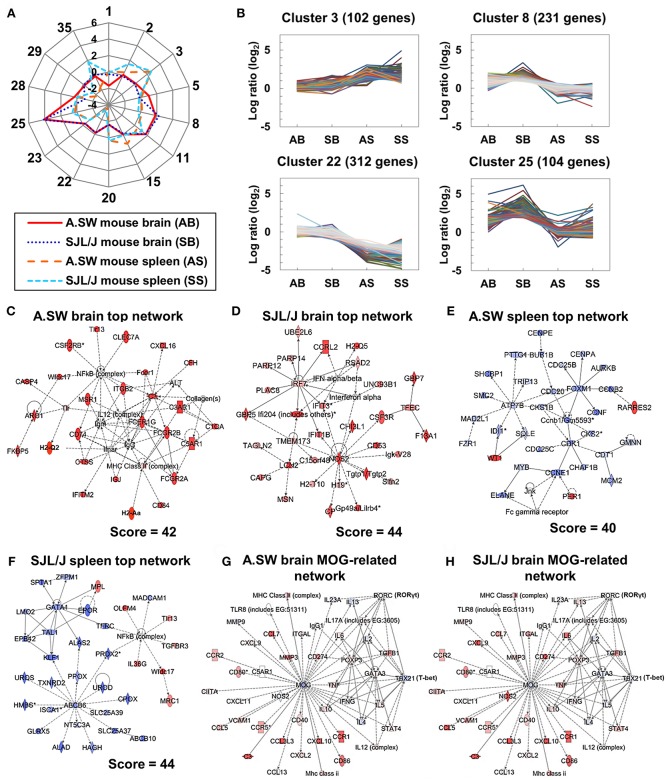
(A,B)
K-means clustering for brain and spleen microarray data from two models. (A) A radar chart of 14 cluster center genes whose log ratios were higher than 1 or lower than −1, at least in one organ or in one mouse strain, compared with controls, among the total 35 clusters. (B) Dynamic expression patterns of four clusters. AB, SB, AS, and SS indicate A.SW mouse brain, SJL/J mouse brain, A.SW mouse spleen, and SJL/J mouse spleen, respectively. We used microarray data from three PP-EAE and three naïve mice of each strain (the total number of mice = 12). Genes in cluster 3 were up-regulated in the spleens of both models. Genes in cluster 8 were up-regulated in the brains of SJL/J mice. Genes in cluster 22 were down-regulated in the spleens of both models. Genes in cluster 25 were up-regulated in the brains of both models. (C–H) Gene networks up-regulated in the brains or down-regulated in the spleens from two models. Transcriptome data at disease peak were clustered and categorized by the Ingenuity Pathway Analysis (IPA) Network Generation. (C) The top network in the brains of A.SW mice was categorized as “Cell-To-Cell Signaling and Interaction,” “Hematological System Development and Function,” and “Immune Cell Trafficking,” which were composed of Fc receptor and complement-related genes. (D) The top network in SJL/J mouse brain was categorized as “Immunological Disease,” “Endocrine System Disorders,” and “Gastrointestinal Disease,” which were composed of IFN-α/β-induced genes and nitric oxide synthase 2 (Nos2). (E) The top network in A.SW mouse spleen was categorized as “Cell Cycle,” “Reproductive System Development and Function,” and “Cancer” which were composed of cell cycle-related genes. (F) The top network in SJL/J mouse spleen was categorized as “Small Molecule Biochemistry,” “Hematological Disease,” and “Metabolic Disease” which were composed of GATA1- and transporter-related genes. (G,H) Up- or down-regulated genes associated with MOG in the brains of A.SW mice (G) and SJL/J mice (H). Pro-inflammatory genes were down-regulated in A.SW mice and up-regulated in SJL/J mice, while Th2-associated genes were up-regulated in A.SW mice and down-regulated in SJL/J mice. Red and blue nodes indicate up- and down-regulated genes, respectively. Solid and dashed lines indicated direct and indirect connections, respectively. Score = network score.